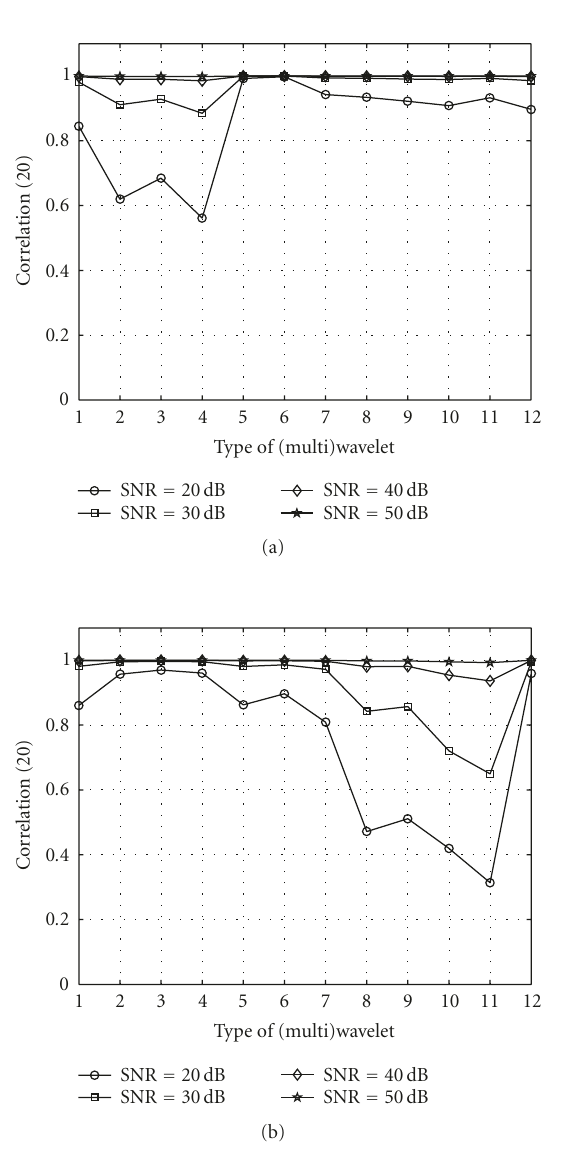
Figure 6: The average correlation values (20) for the plane objects with (a) multiwavelet coe ffi cients and (b) multiscaling function co- e ffi cients; x -axis corresponds to the (multi)wavelets used in this sec-